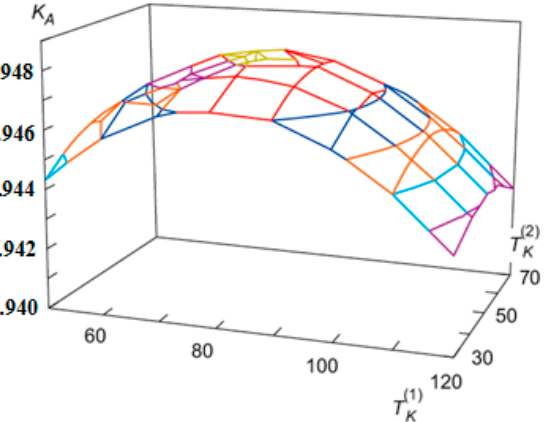
Figure 11. Dependence of the readiness coefficient K A on the TIBV for the first and second degradation groups.